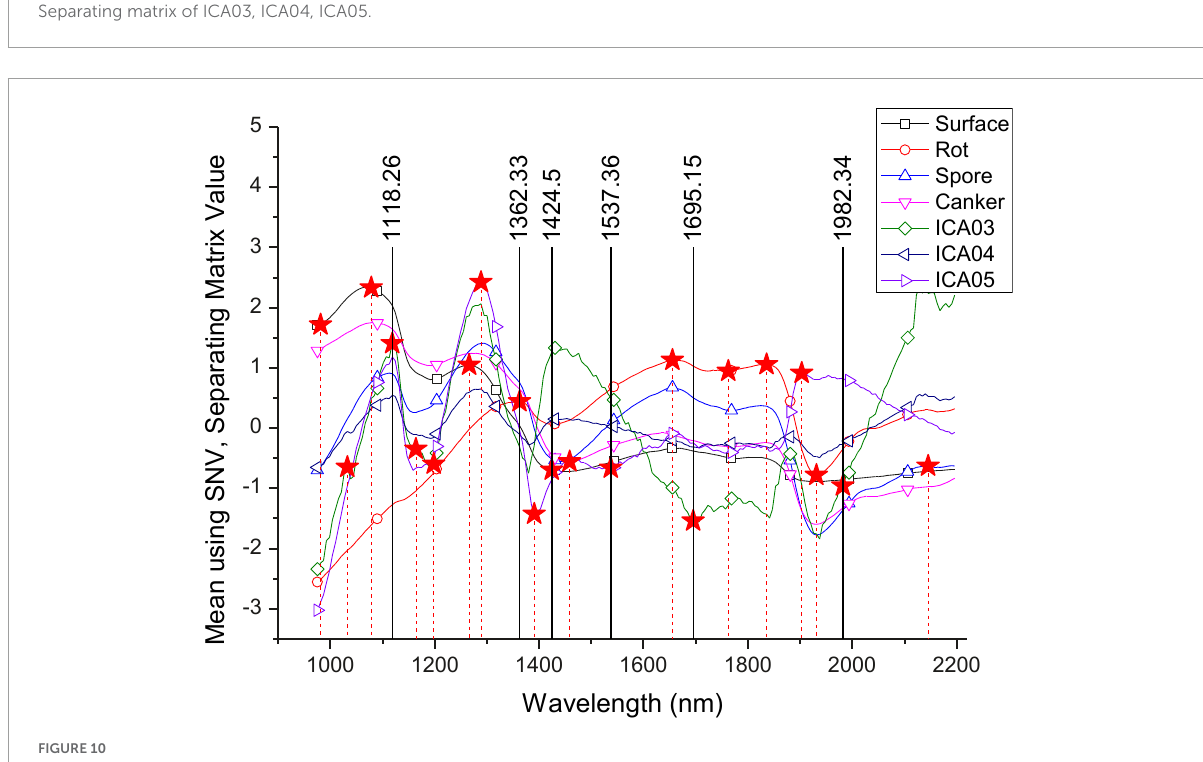
FIGURE10 Selection of characteristic wavelengths.